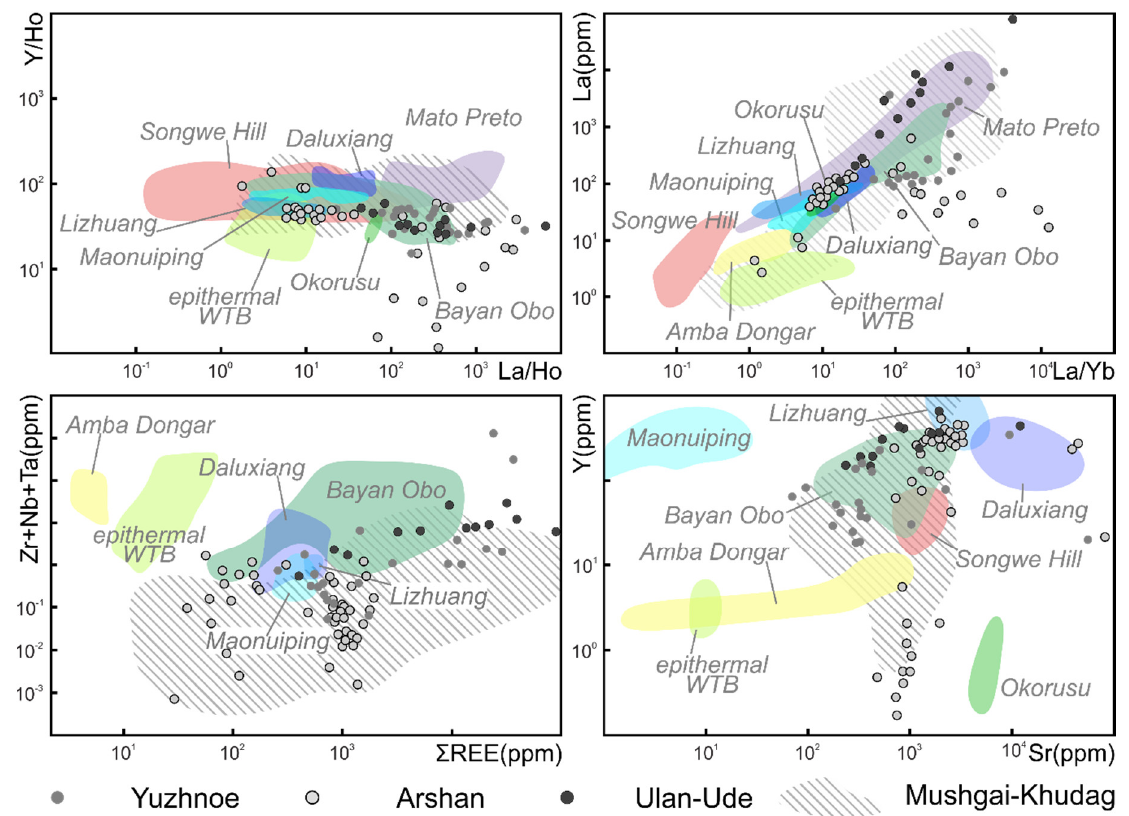
Figure 6. Plots of the Western Transbaikalia fluorites vs fluorites from REE deposits. (Amba Dongar [1]; Daluxiang, Lizhuang, Maonuiping, Bayan Obo [4–6]; Mato Preto [1]; Songwe Hill [3]; Okorusu [36]; epithermal WTB (epithermal fluorite deposits of the Western Transbaikalia) [10]; Mushgai-Khudag [7].